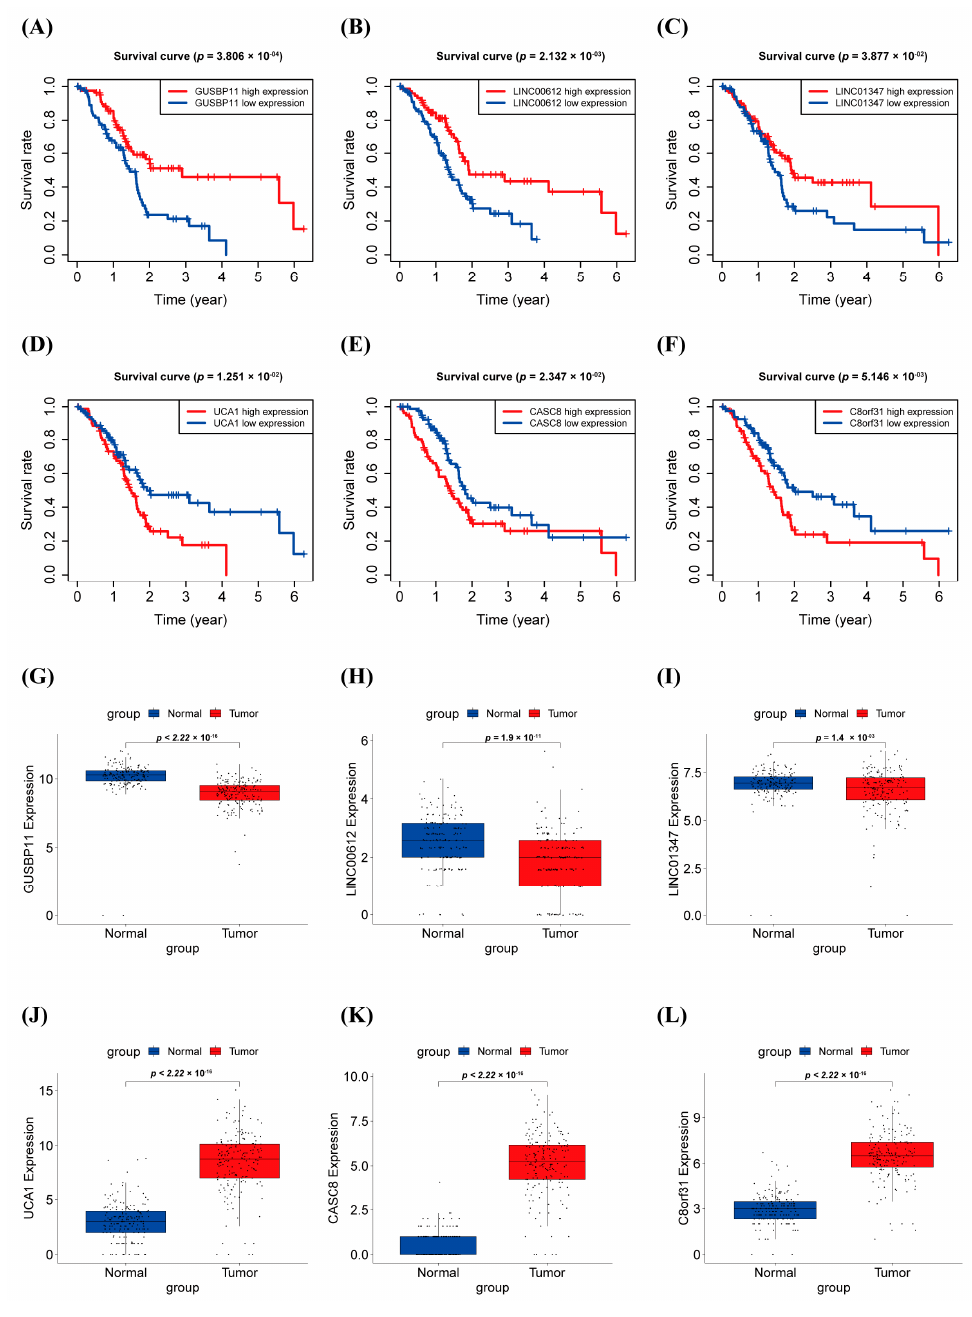
Figure 3. Survival curve and expression level in PAAD of warlncRNAs. ( A – F ) Kaplan–Meier survival curves for six prognostic warlncRNAs (all p < 0.05). ( G – L ) The expression level of six prognostic warlncRNAs in Normal and PAAD patients.